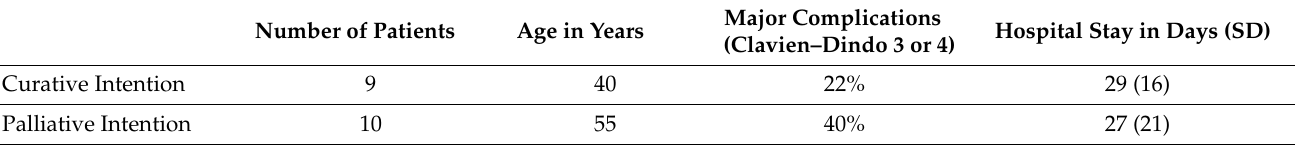
Figure 3. Overall survival. ( A ) Kaplan–Meier survival curve after primary diagnosis of sarcoma is shown. ( B ) These Kaplan–Meier curves show survival after the diagnosis of peritoneal sarcomatosis has been made. Table 5. Treatment intention and